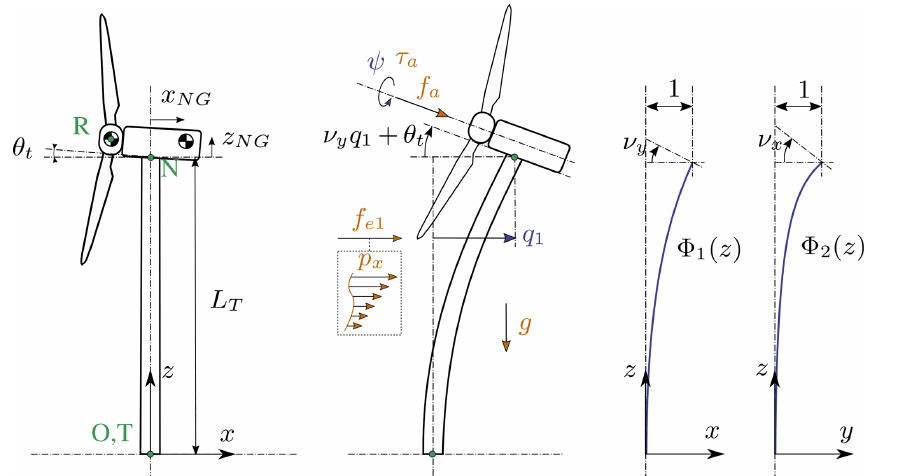
Figure 4. Model of a land-based or fixed-bottom wind turbine using 1 to 3 degrees of freedom (fore–aft and side–side flexibility of the support structure, as well as shaft rotation). Points are indicated in green, degrees of freedom in blue, and loads in